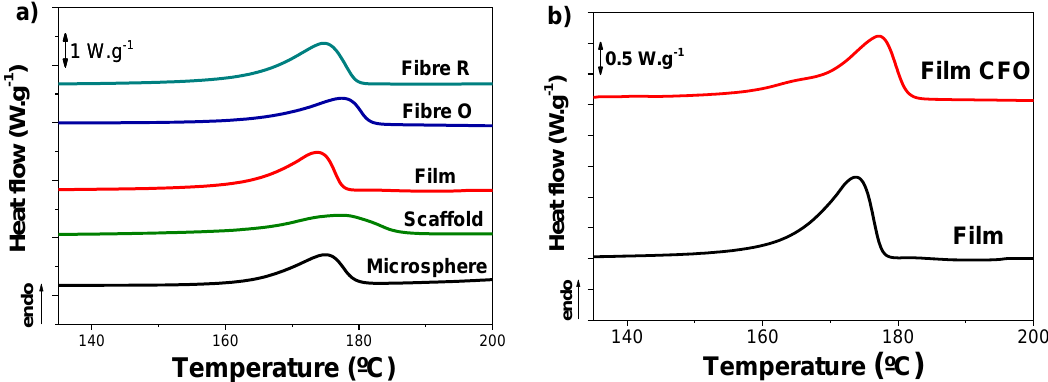
Figure 3. DSC thermograms for ( a ) different neat PHBV morphologies and ( b ) PHBV films and films composites. Table 1. T m , Δ H m , and crystallinity degree of all PHB and PHBV composite samples. The associated error is ±2%.